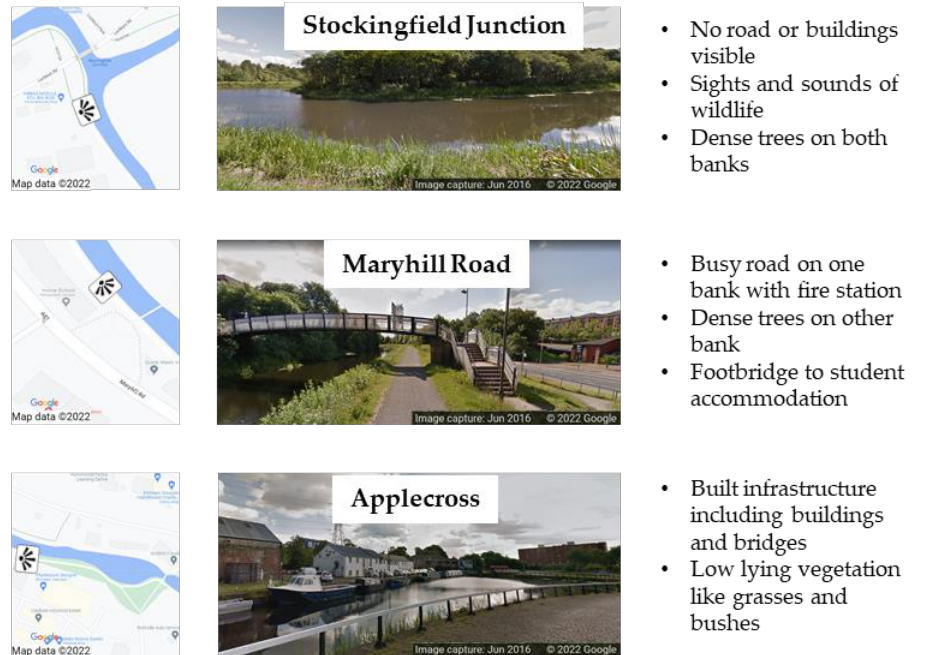
Figure 2. Annotated image of each study site to provide the reader an opportunity to have their own perception of the space. Maps and images © Google, 2022.